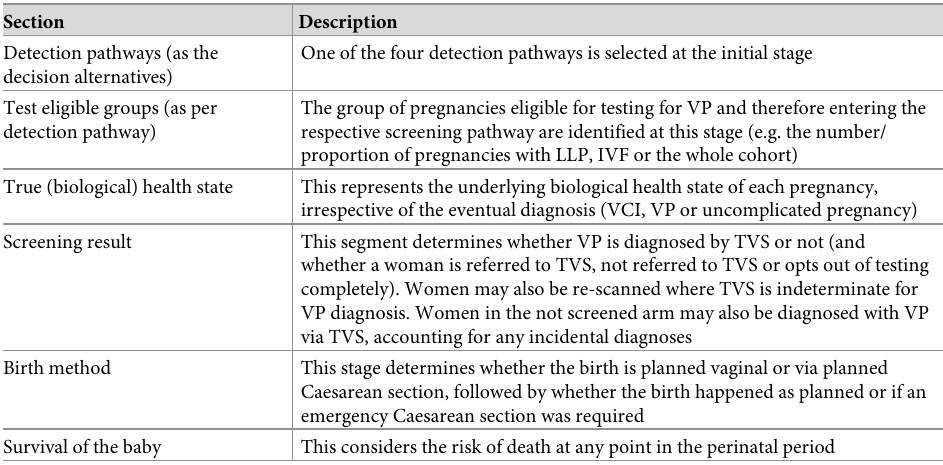
One of the four detection pathways is selected at the initial stage